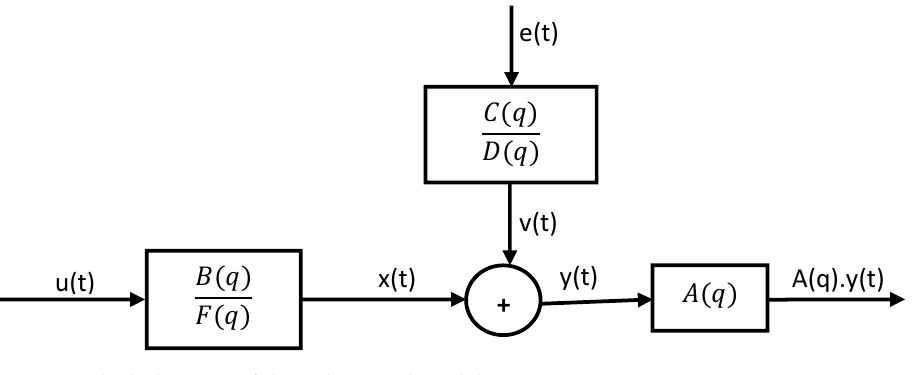
Figure 1. Block-diagram of the polynomial model.